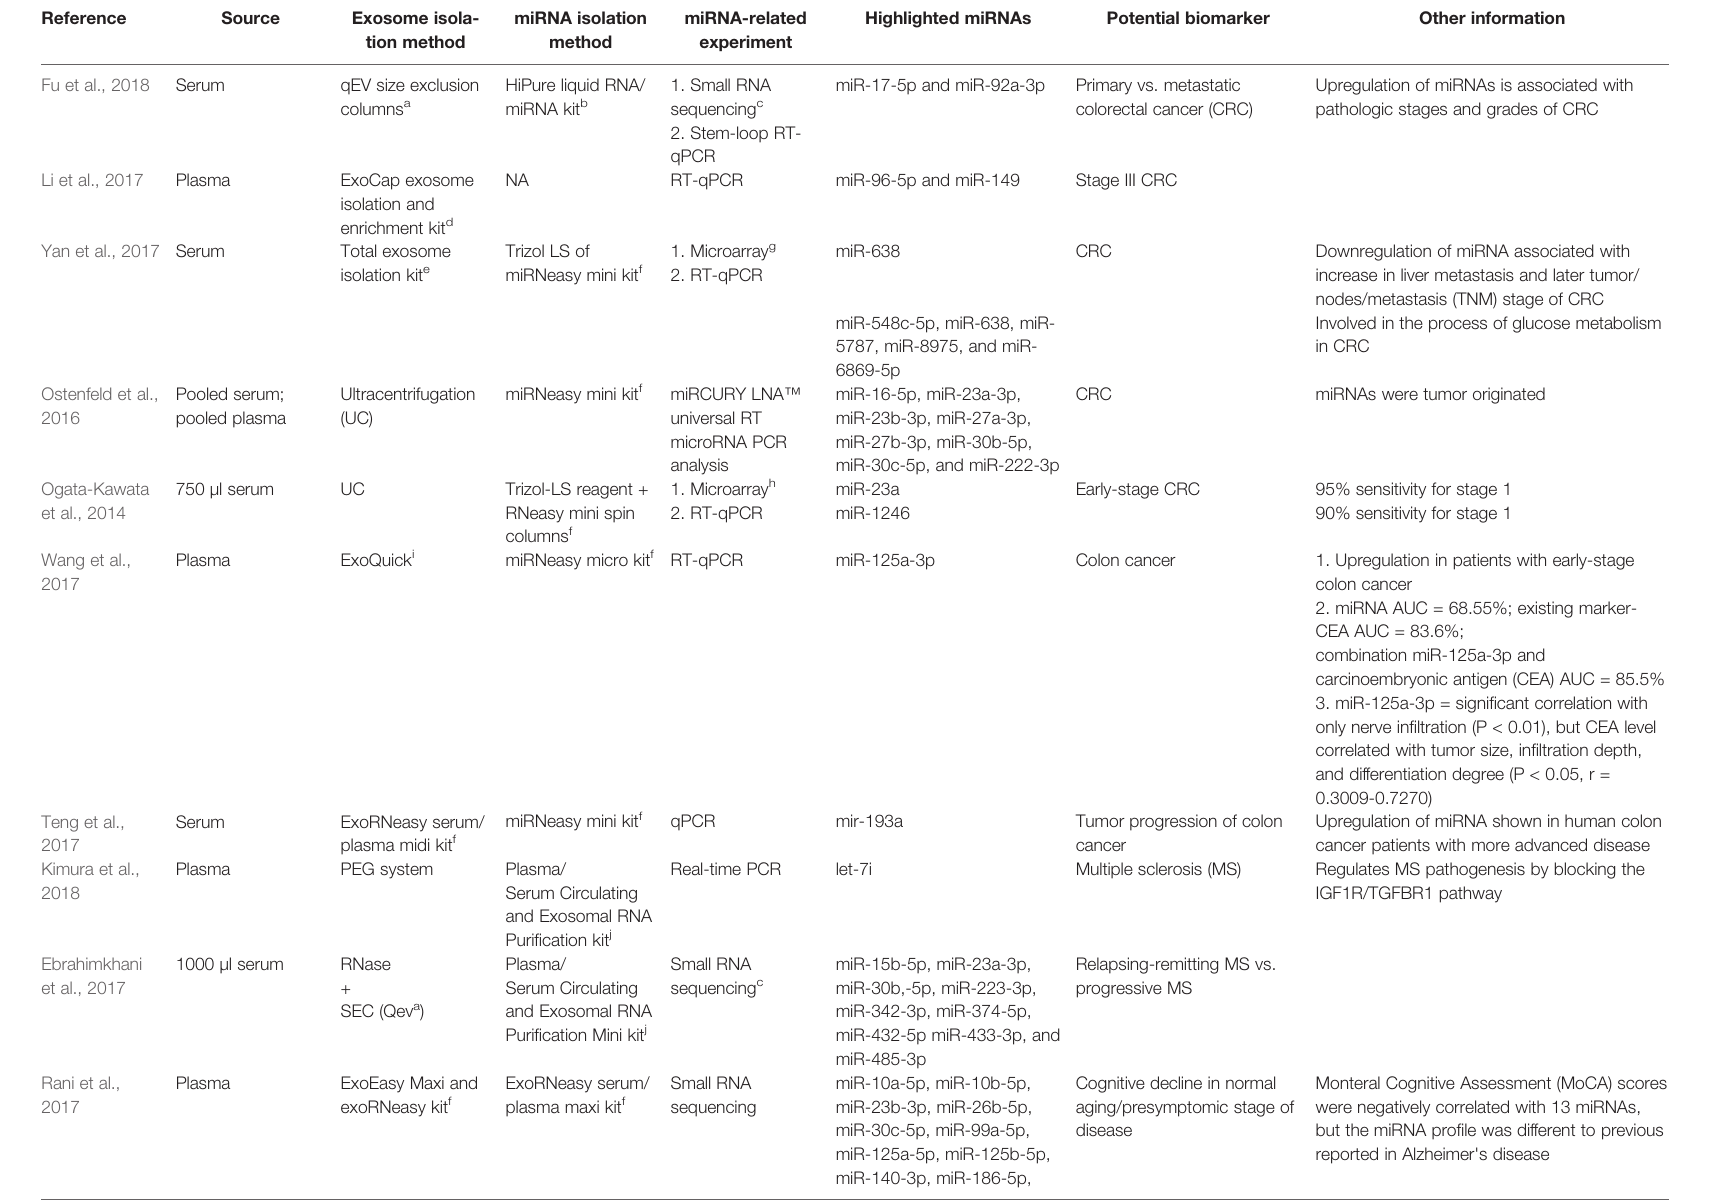
TABLE 2 | Summary of original articles involving exosomal miRNAs as